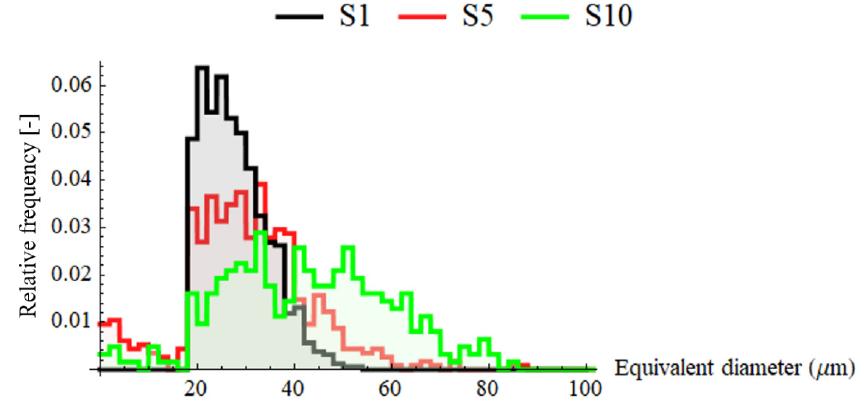
Figure 7. Distributions of equivalent diameters calculated for S1, S5 and S10 surfaces using motif analysis.